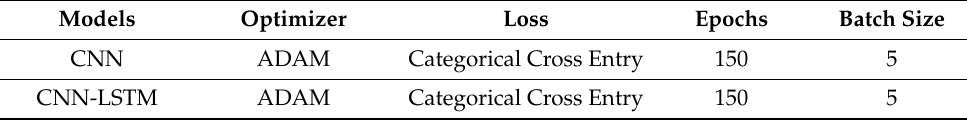
Table 3. Hyperparameters of deep learning